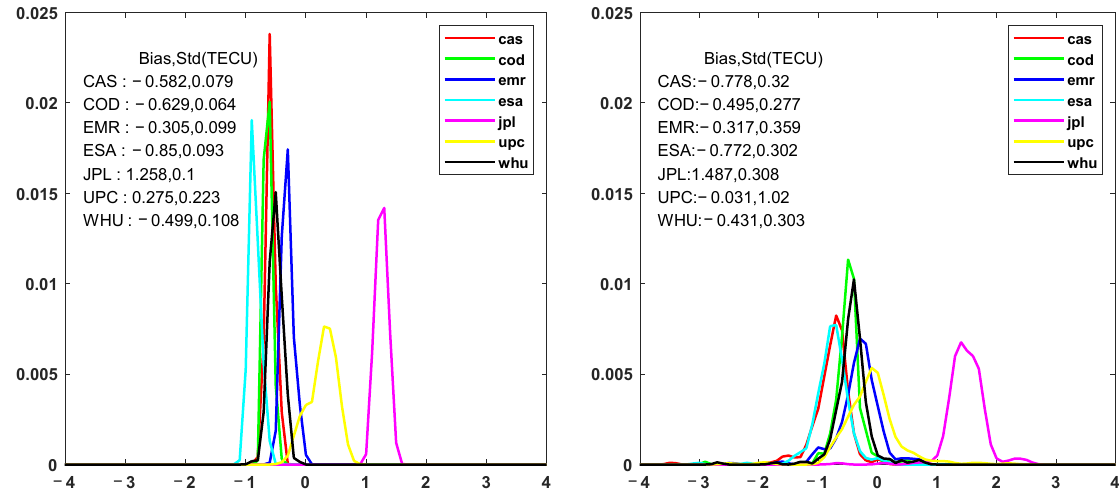
Figure 4. Kernel density estimation curves for different GIMs model deviations. Considering the different level of ionospheric activity at different latitudes, the region from − 85 ◦ S to 85 ◦ N is divided into six latitude bands, as shown in Section 2.5. The accuracy of GIMs in each latitude band is shown as Figure 5, where N and S represent the Northern and Southern Hemispheres, respectively; H, M, and L represent the high, mid, and low- latitude bands. It can be found that different GIMs demonstrate different performance levels among the latitude bands. The results show that the RMS values of high, middle, and low latitudes in the Northern and Southern Hemispheres are 1.751 TECu, 1.755 TECu, and 1.912 TECu and 0.964 TECu, 1.152 TECu, and 2.054 TECu, respectively. It is observed that the consistency of different GIMs with the IGS final GIM is best in the high-latitude band and worst in the low-latitude band, regardless of the solar activity level. This is mainly caused by the presence of equatorial anomalies in the ionosphere of the low-latitude band and the mid-latitude band. Meanwhile, the RMS values in the Northern Hemisphere